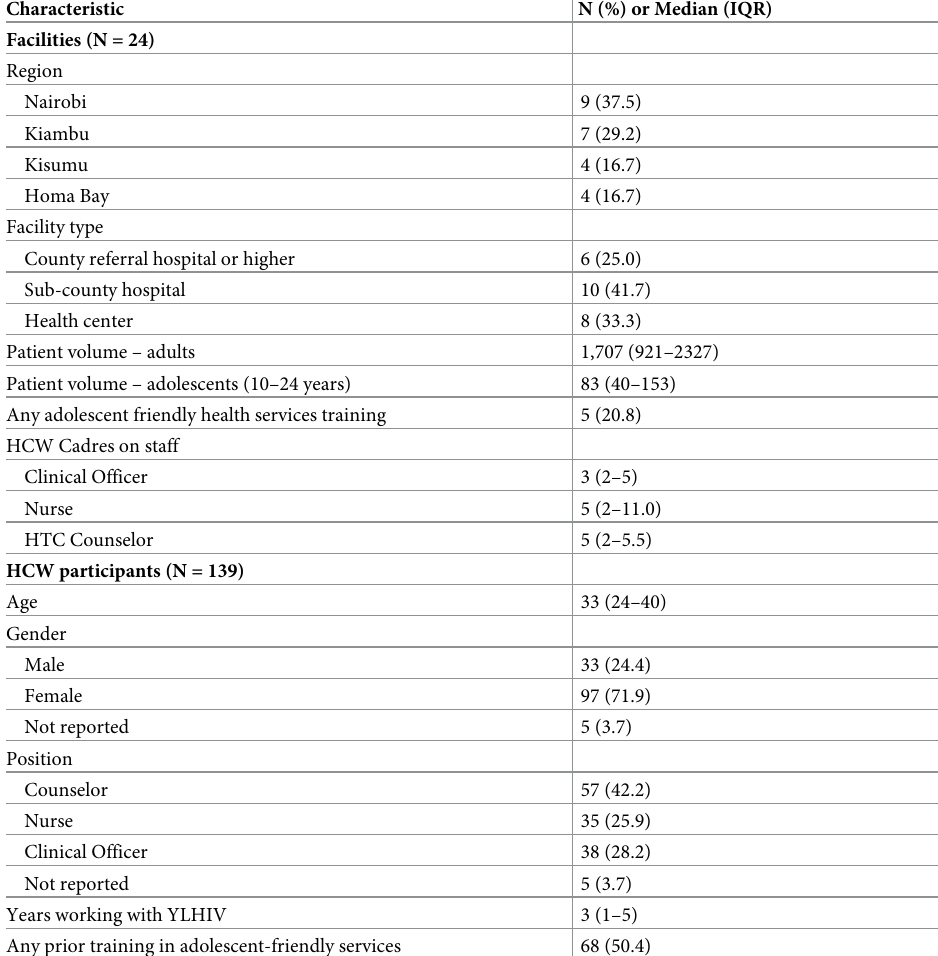
Table 3. Baseline characteristics of